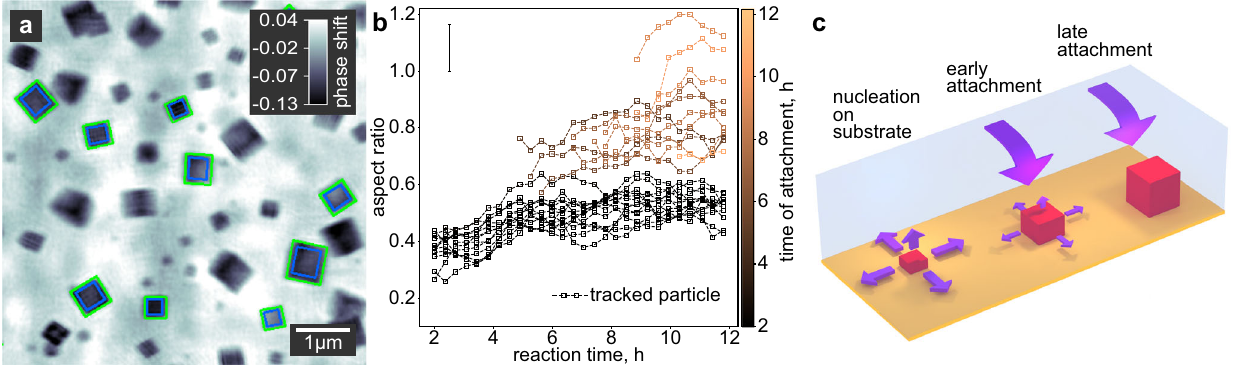
Fig. 4 | Analysis of the growth process from a 3D perspective. a In situ pty- chographic image highlighting the in-plane dimension of the nanocuboids by green rectangles. The out-of-plane thickness is calculated from the phase shift within the area highlighted by blue rectangles. The gray scale indicates the quan- titative phase shift of the image in radian. b Evolution of the aspect ratio for all particleshighlightedinFig.3b.Theaspectratioiscalculatedasthequotientofthe in-plane dimension and the out-of-plane thickness of the nanocuboids. A moving average(MA)windowoffourtimestepsisapplied.SeeSupplementaryFig.12fora